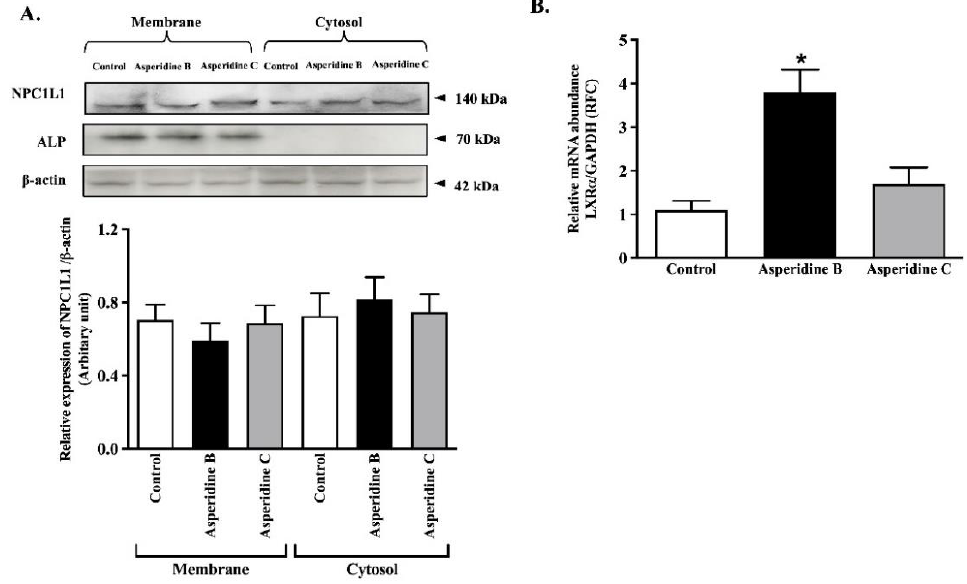
Figure 4. Expression of NPC1L1 and LXR α in Caco-2 cells. Cells were incubated with 100 µ M asperidines B and C for 3 h. ( A ) Membrane and cytosolic fractions expressing NPC1L1 were detected by electrophoresis and a Western blot analysis. Anti-alkaline phosphatase (ALP) and anti- β -actin antibodies were used as a membrane marker and loading control, respectively. A representative blot of NPC1L1 protein expression is shown in the top panel and quantification of relative NPC1L1/ β -actin protein expression in each fraction is presented at the bottom. ( B ) Total RNA was extracted from Caco-2 cells and LXR α mRNA levels were determined using qPCR. Data are expressed as mean ± SEM from five separate experiments. Data are represented as mean ± SEM ( n = 3); * p < 0.05 vs. control.